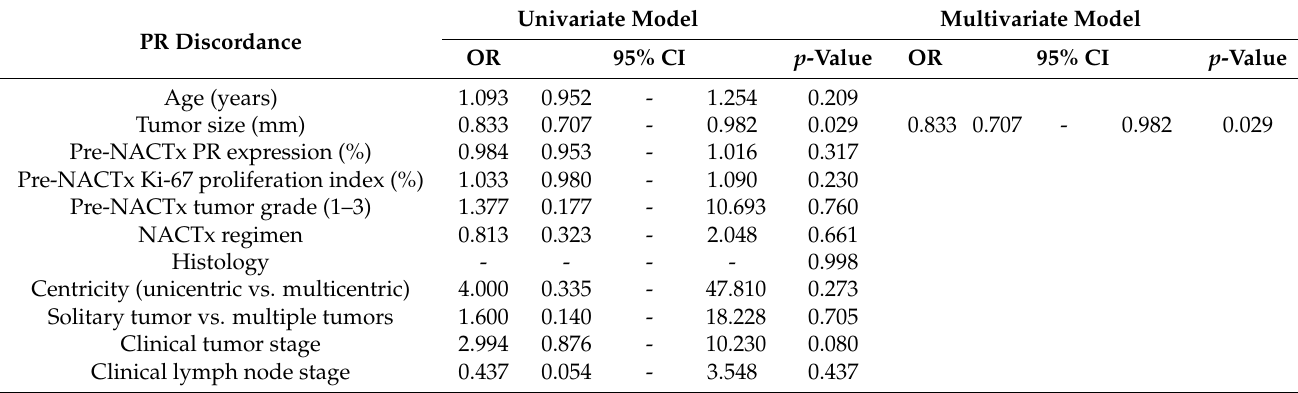
Table 4. Binary logistic regression analysis for PR